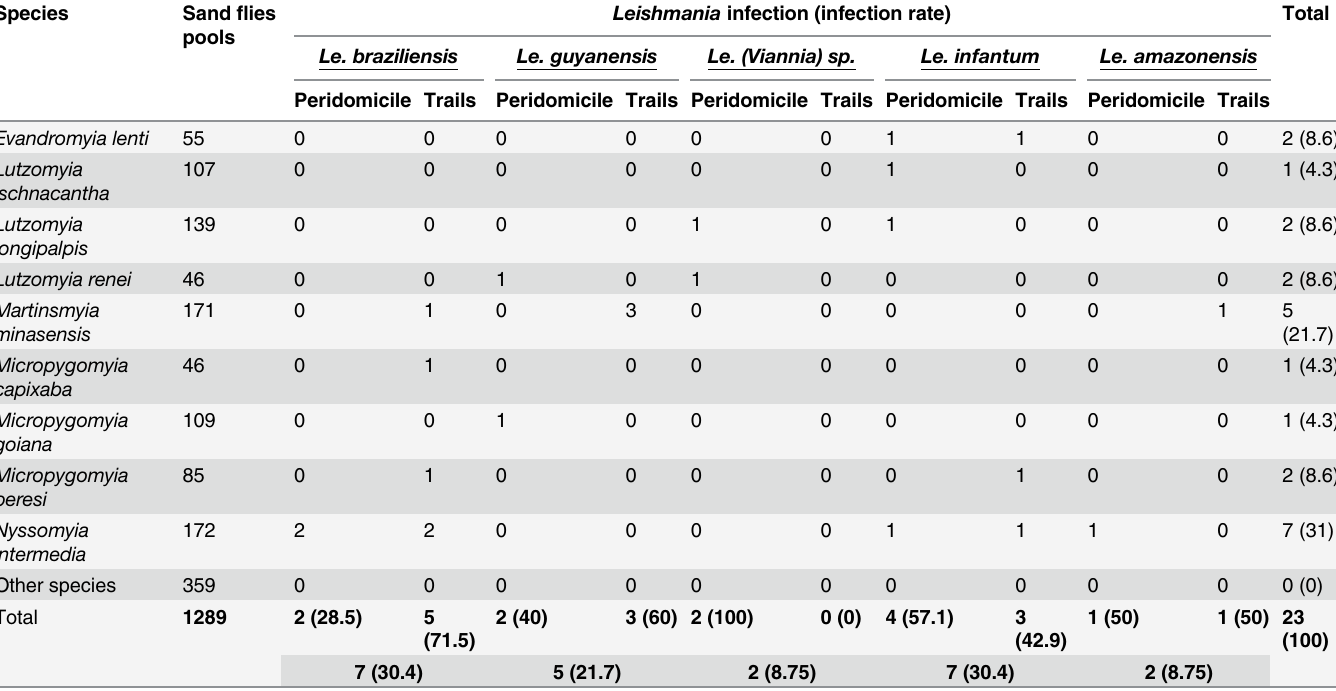
Table 3. Pools of phlebotomine sand flies species naturally infected by Leishmania by collection site within the Xakriabá Indigenous Reserve,